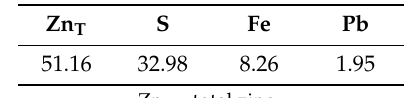
Table 1. Main chemical composition of zinc sulfide concentrate (mass fraction, %).